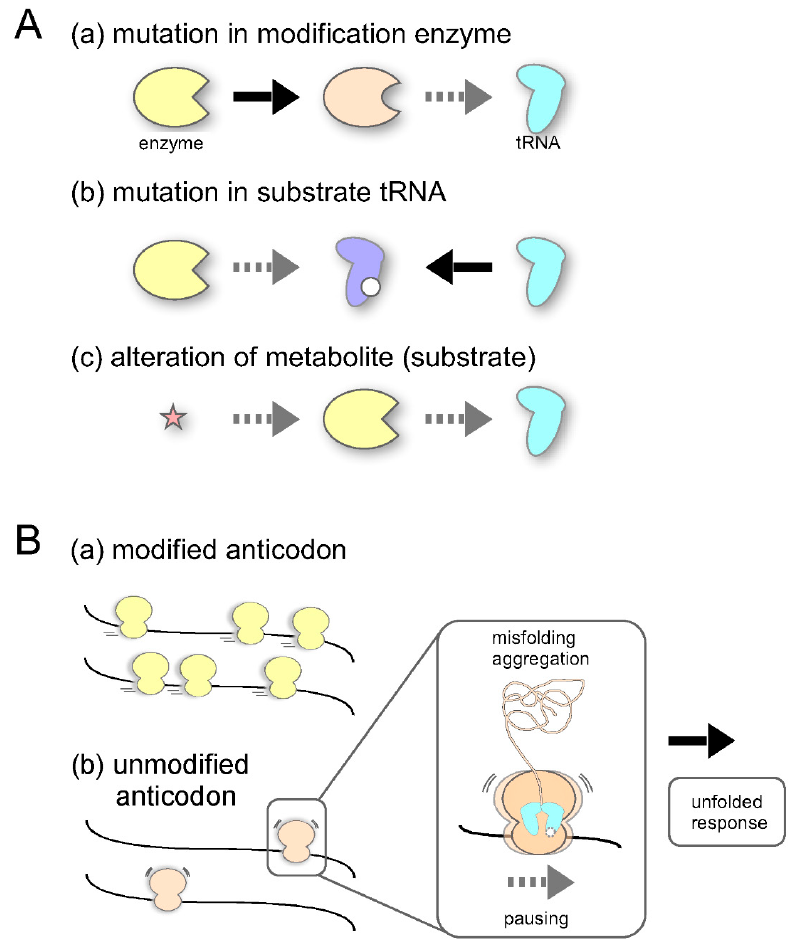
Figure 4. Disorders in RNA modification: ( A ) Three pathways via which aberrations can occur in tRNA modification. ( B ) (a) mRNAs that have many more XAA codons (for Lys, Glu, and Gln) can be effectively read with modified anticodons, which leads to proper folding of the proteome. (b) Only the translation of codon-biased genes is affected if there is no modification in the anticodon. Slow translation causes misfolding and aggregation of the proteome, which leads to the unfolded response.